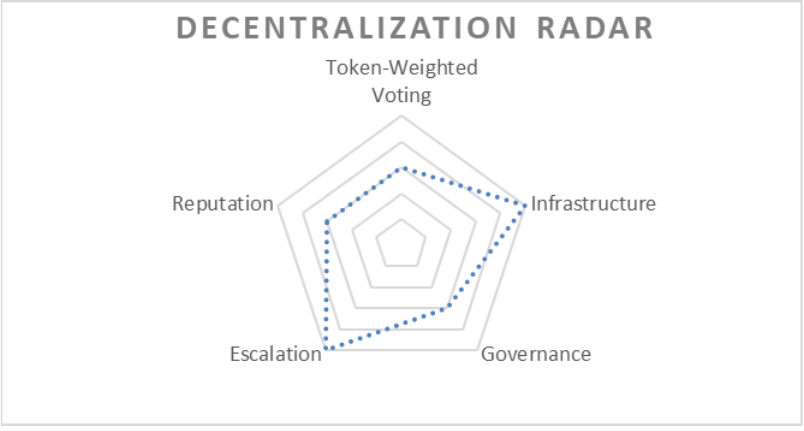
Figure 4. Compound decentralization radar